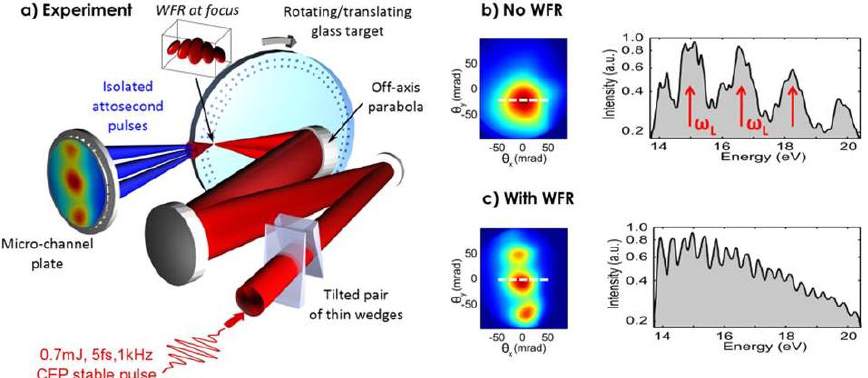
Figure 6. Asec ligthouses from plasma mirrors. ( a ) Schematic of the experimental set-up. ( b ) Measured XUV beam profile in the absence of WFR for a fixed arbitrary CEP value (left panel) and the corresponding XUV spectrum at the center of the XUV beam profile (right panel). ( c ) Measured XUV beam profile in the presence of WFR for a fixed arbitrary CEP value (left panel) and the corresponding XUV spectrum at the center of the spatial XUV beam profile (right panel). From Ref. [67].